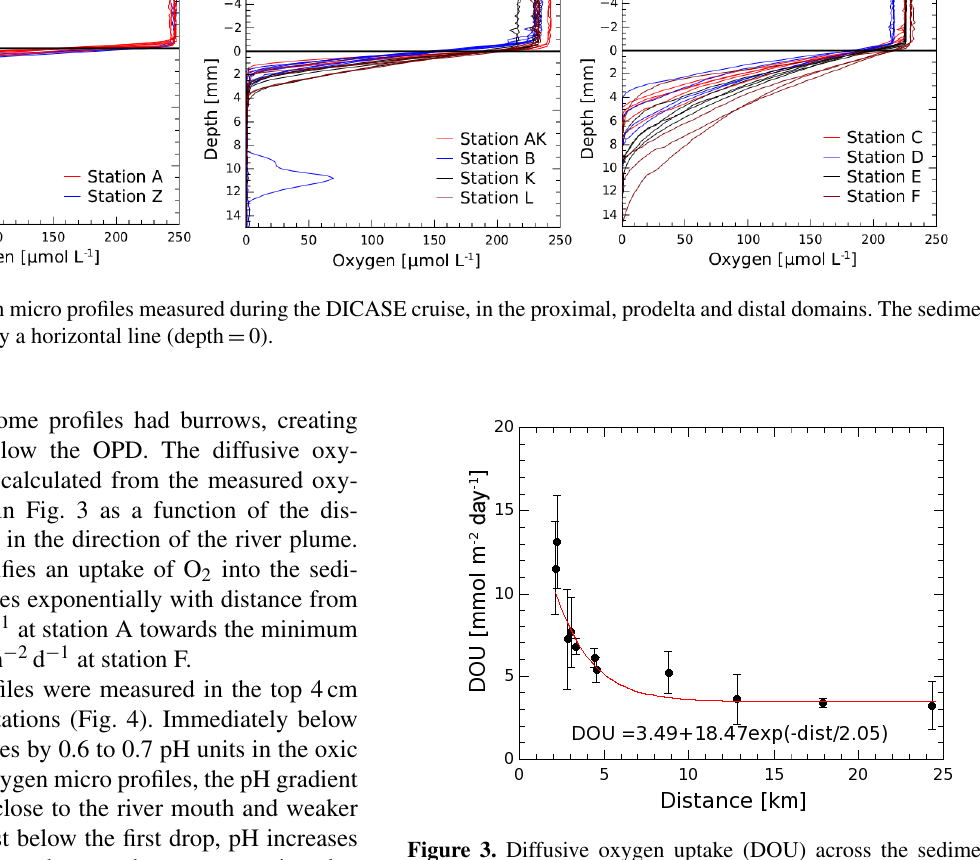
Figure 3. Diffusive oxygen uptake (DOU) across the sediment– water interface as a function of the distance from the Rhône River mouth. The fluxes decrease exponentially following DOU = F min + Ae ( − x/t) , with F min being the flux in the offshore region, x the dis- tance to the river mouth in km and A and t being the numerical constants. Error bars are standard deviations between the diffusive fluxes calculated from the five single oxygen profiles measured at each